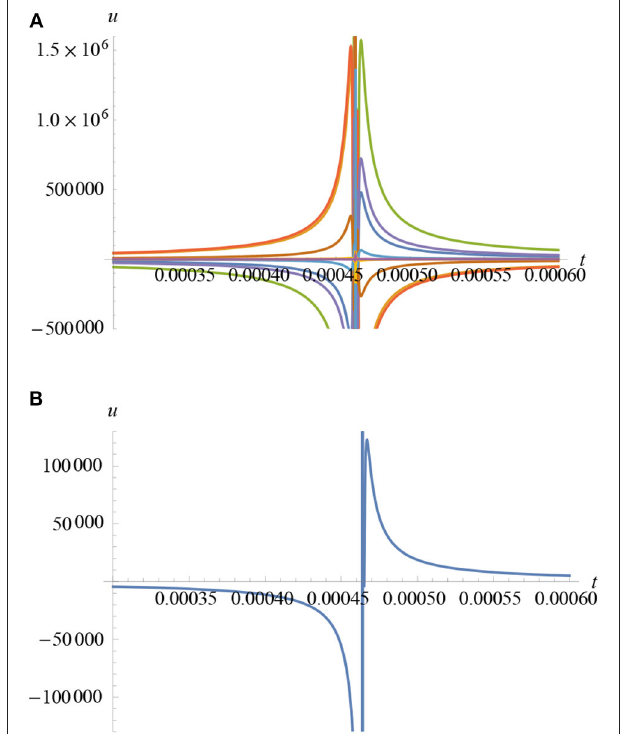
FIGURE 8 | (A) The variation of wave-pressure vs. time for a series of different transmitted and reflected waves described by Equation (75). (B) The variation of wave-pressure vs. time for the superposition of each of the waves in (A) there is a chaotic region of highly alternating pressure close to t